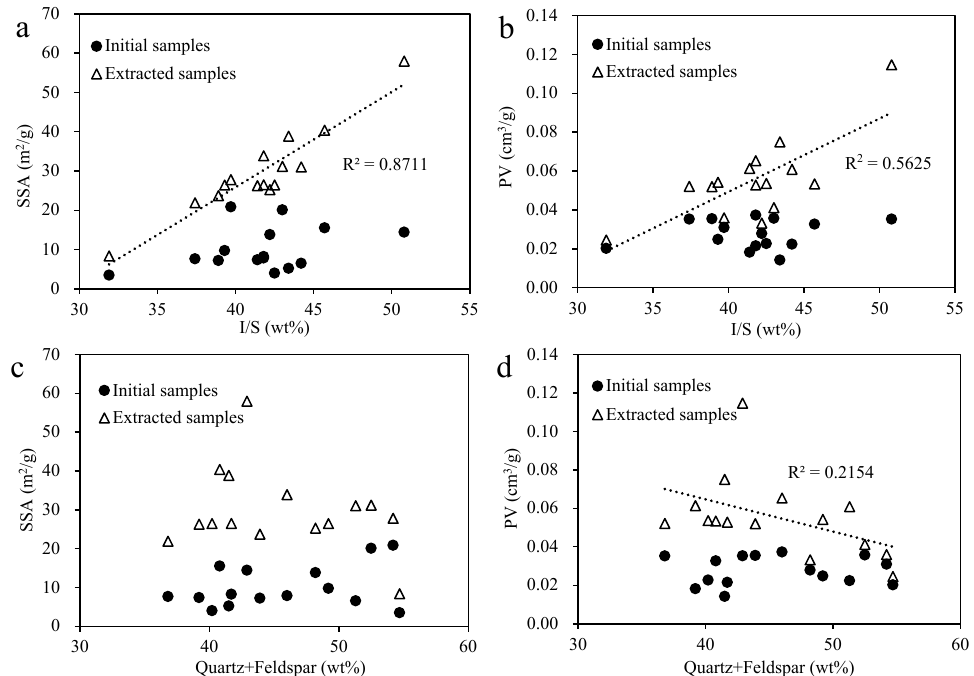
Figure 7. Correlation between the mineral contents and pore structure parameters. ( a ) I/S vs. SSA; ( b ) I/S vs. PV; ( c ) Quartz + Feldspar vs. SSA; ( d ) Quartz + Feldspar vs. PV. The I/S mineral contents show clear positive linear correlations with both the SSA and PV (Figure 7a,b), indicating that this clay mineral is one of the key controlling factors in pore structure of the K 2 qn shales. The I/S mineral contents show a better correlation with SSA (R 2 of 0.8711) than that with PV (R 2 of 0.5625), suggesting that the surface area or small pores of the K 2 qn shales are primarily associated with the I/S mineral. As shown